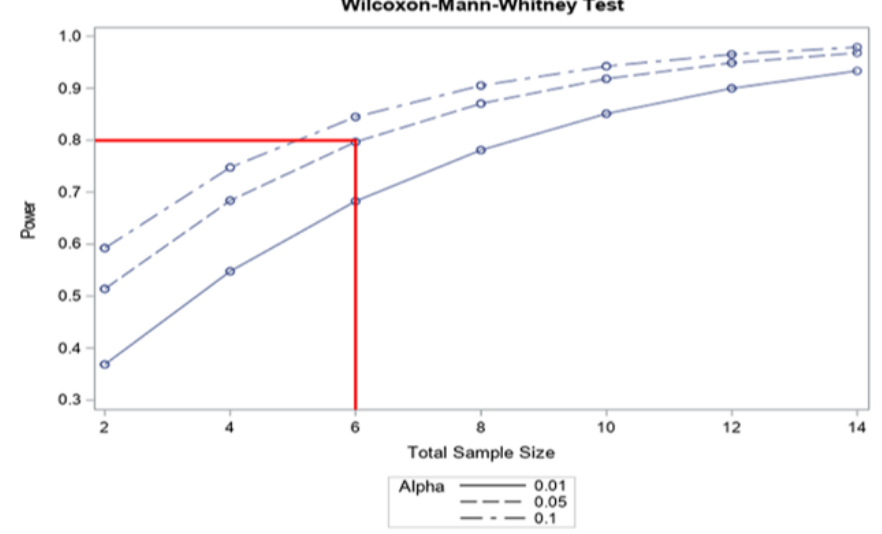
Figure 2. The power calculation.